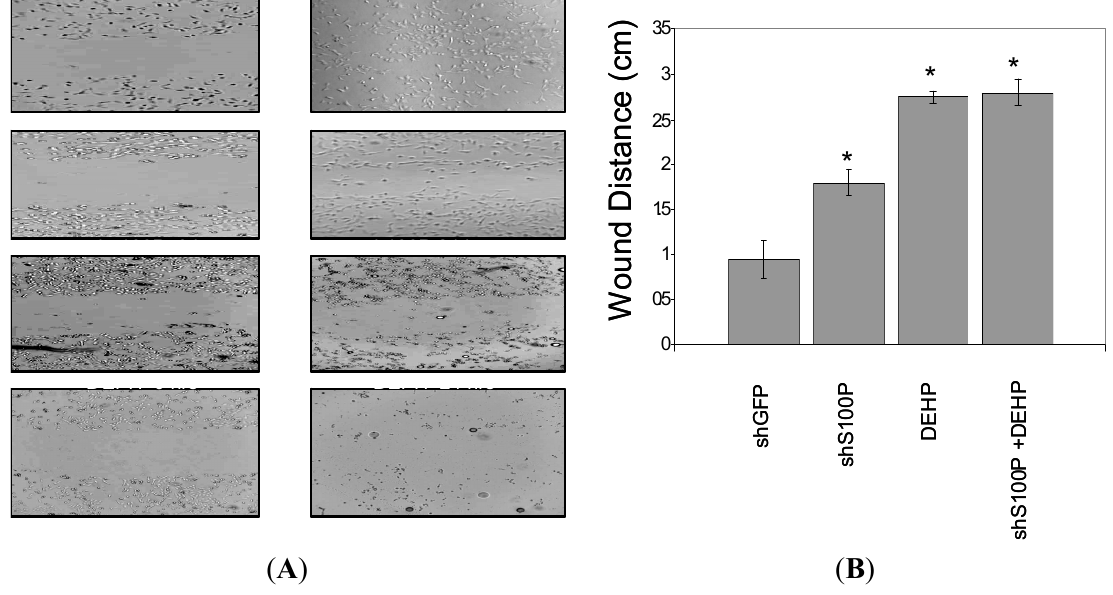
Figure 5. Wound healing/migration of LN-229 cells. ( A ) Representative micrographs showing LN-229 cells migration a 0 time point and after 24 h following treatment with DEHP alone and in combination with S100P knockdown. ( B ) Quantitative analysis of LN-229 cells wound distance (cm) after 24 h of treatment with DEHP alone and in combination with S100P knockdown is presented as mean ± SEM of experiments performed in